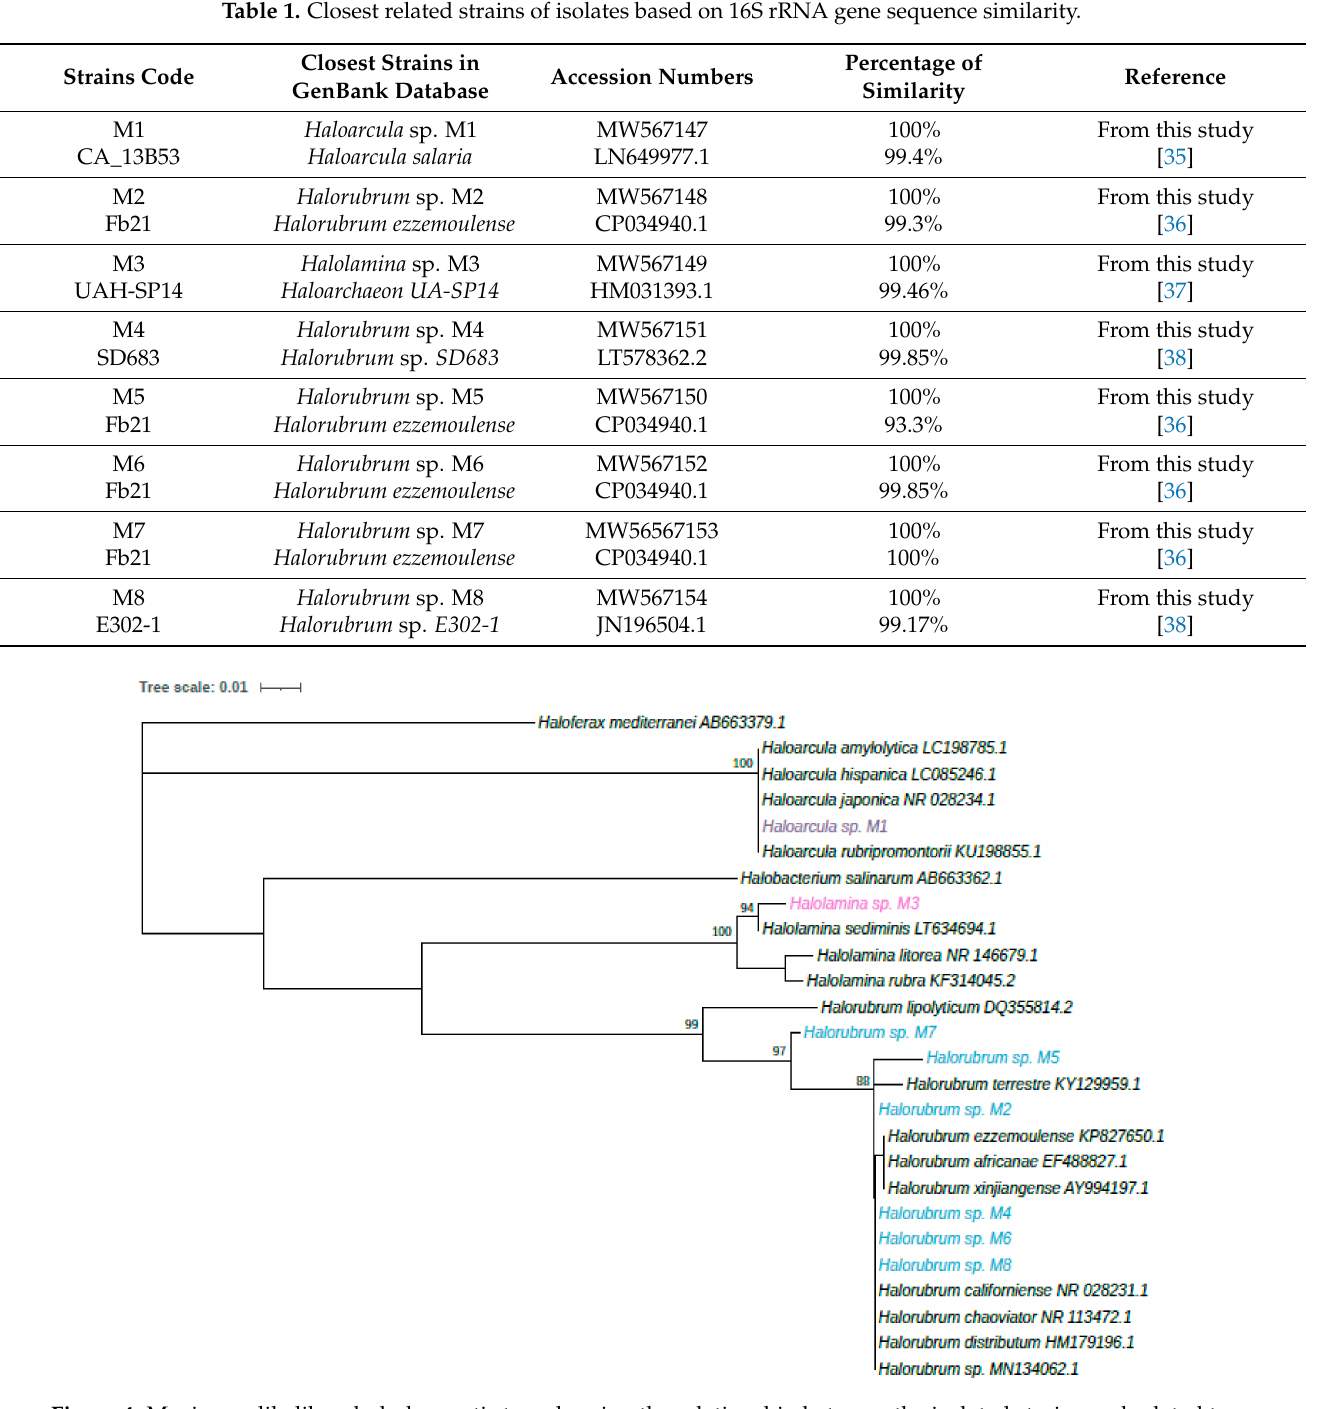
Figure 4. Maximum likelihood phylogenetic tree showing the relationship between the isolated strains and related taxa. Reconstruction was based on partial 16S rRNA sequences with the calculated T92+1 evolutionary model. Bootstrap values, indicated at nodes harboring the studied strains, were obtained from 1000 bootstrap replicates and are reported as percentages. Haloferax mediterranei was used as the outgroup. The closest reference strains are shown in